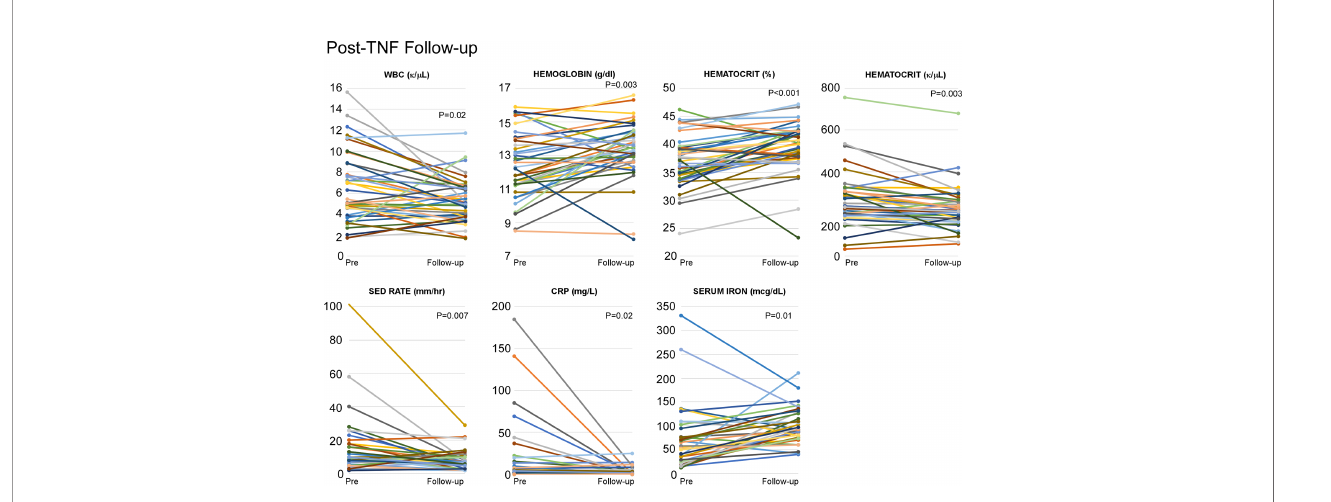
FIGURE 13 | Anti-TNF agents help to reduce the in fl ammatory burden in DADA2 patients. Analysis of individual in fl ammatory burden (ESR, CRP, WBC, hemaglobin, hematocrit, platelet count, and serum iron) was completed both pre- and post-anti-TNF initiation. There were statistically signi fi cant decreases in WBC (p=0.01), platelet count (p=0.003), ESR (p=0.007), CRP (p=0.02) as well as statistically signi fi cant increases in hemoglobin (p=0.03), hematocrit (p=0.001), and serum iron